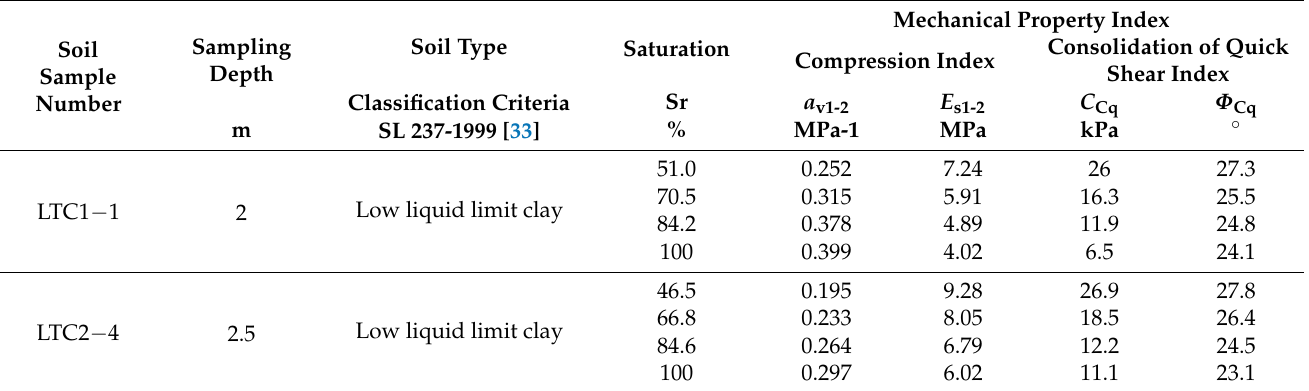
Table 3. Effect of saturation on mechanics index of soil in Luohuang